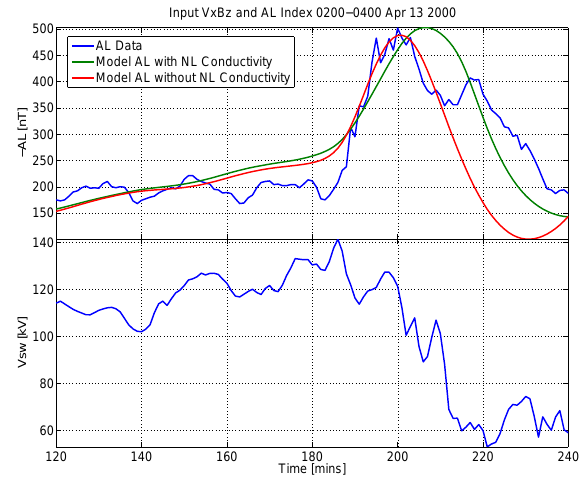
Fig. 3. 13 April 2000 substorm analysis with the WINDMI model. The result when using only a reconnection trigger (ARV = 0.71) is compared to the result when conductivity enhancement (ARV = 0.32) is also included.